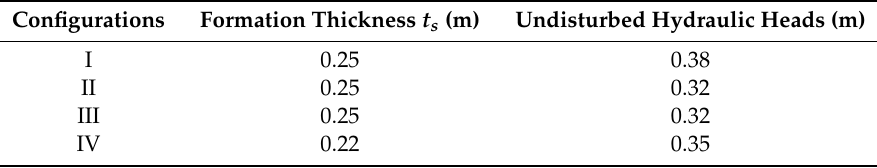
Table 1. Values of formation thickness and undisturbed hydraulic heads.